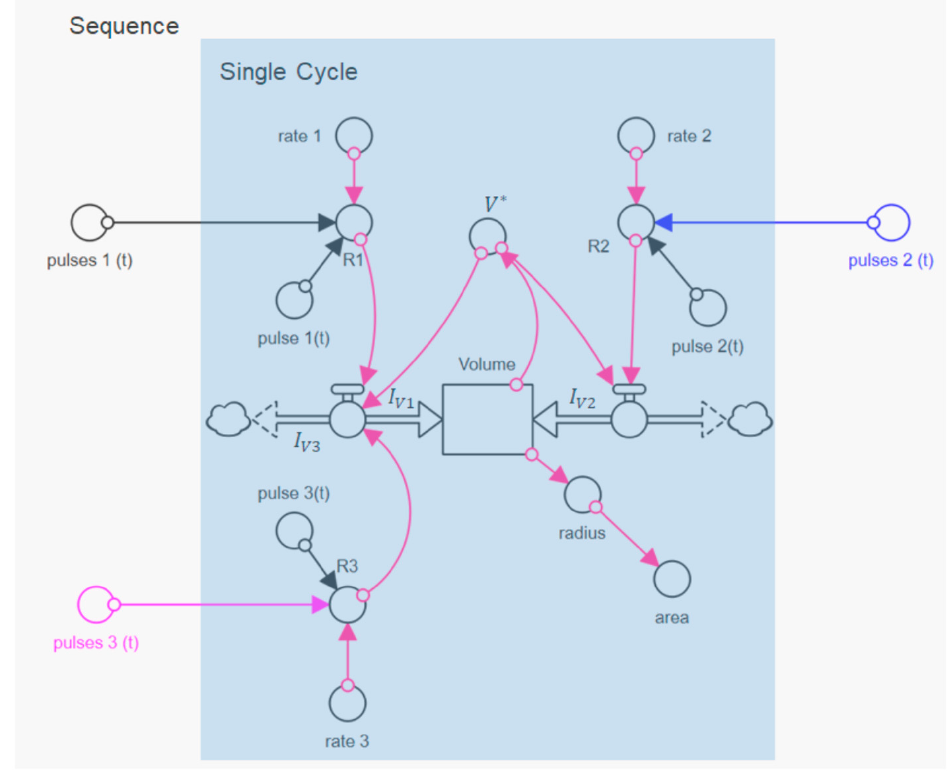
Figure 4. Dynamic STELLA model for the simulation of individual swelling and de-swelling cycles and a sequence of cycles.